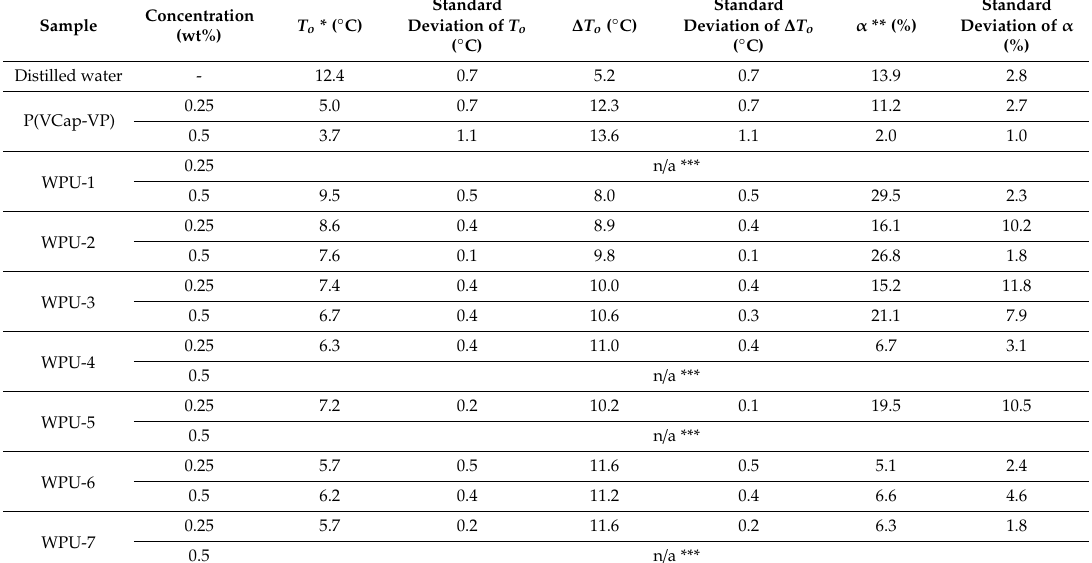
Table 1. The results of ramping experiments by rocking cell technique.